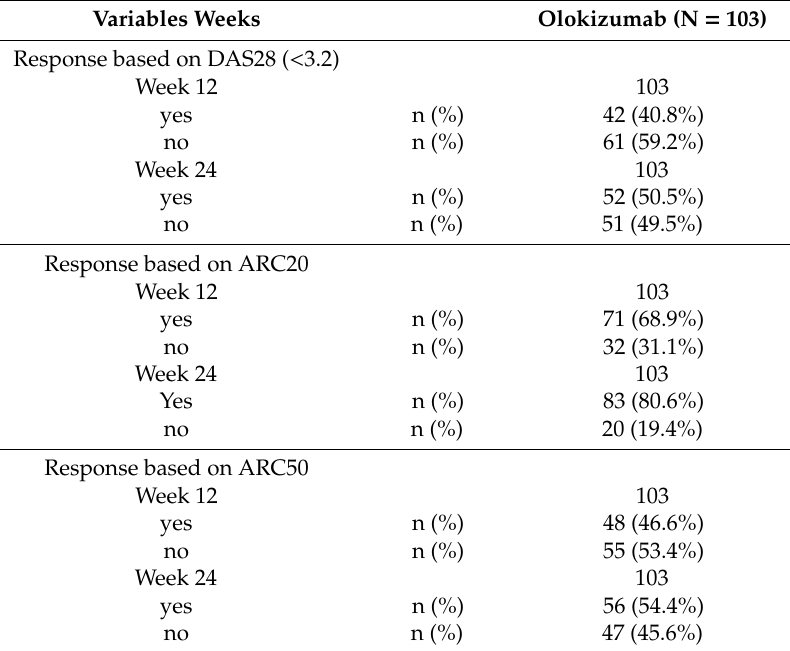
Table 3. E ffi cacy of olokizumab therapy.